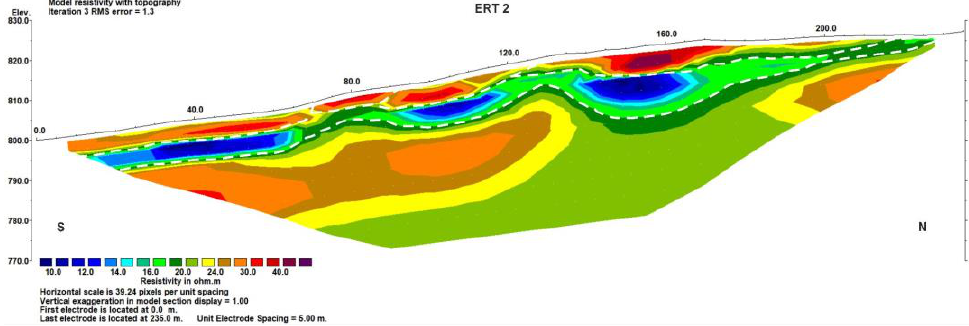
Figure 11. Electrical resistivity tomography (ERT 2) carried out parallel to the landslide body along the middle part. Dashed white lines outline possible sliding surfaces. Elev.: elevation above sea level.